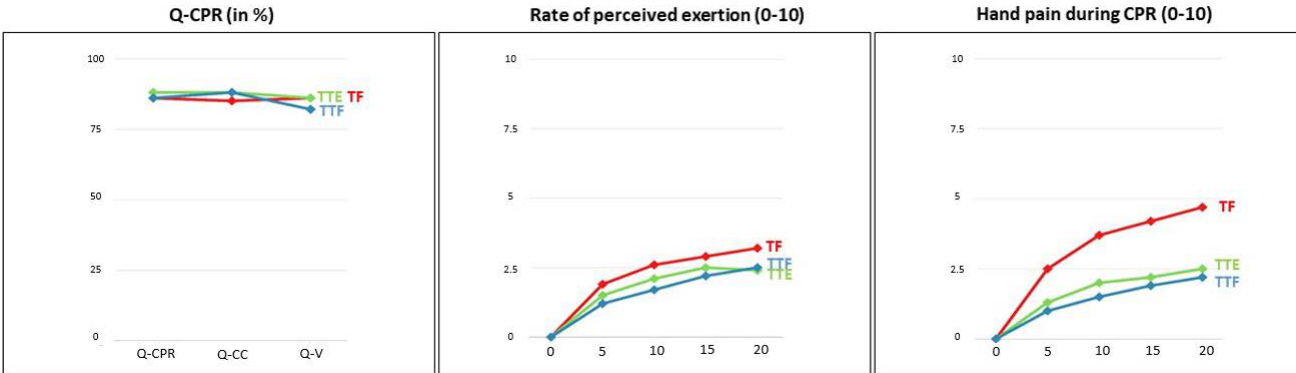
Figure 3. Chart of the